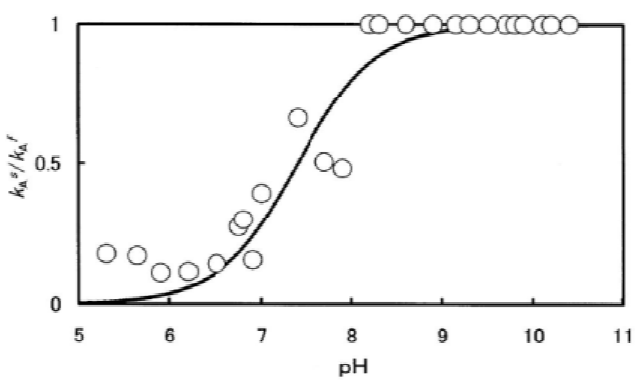
autoxidation. The solid line stands for 2 , a = a